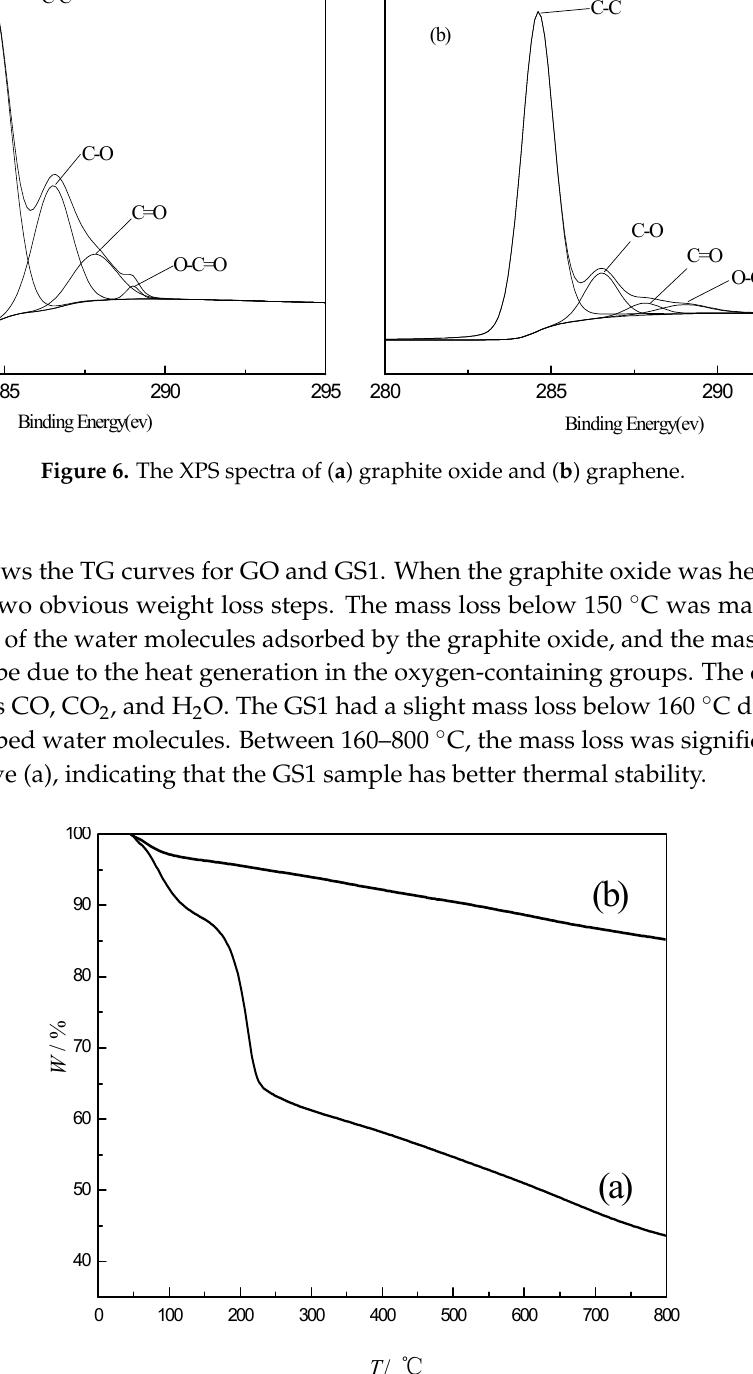
Figure 7. Thermogravimetric curves of (a) GO and (b) GS1.